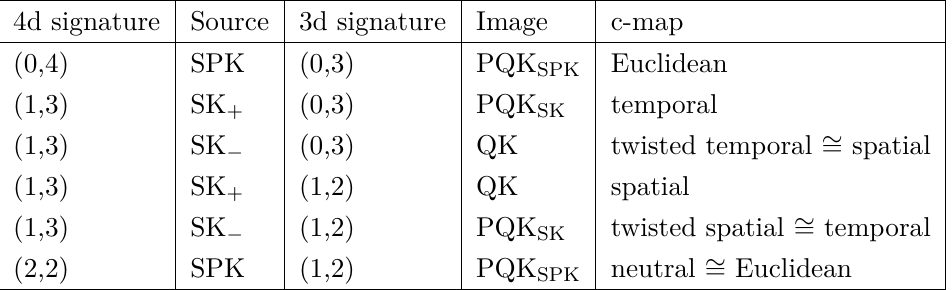
Table 5 . When reducing four-dimensional vector multiplets to three dimensions, there are six distinct cases, although there are only three distinct types of hypermultiplet manifolds that arise from the